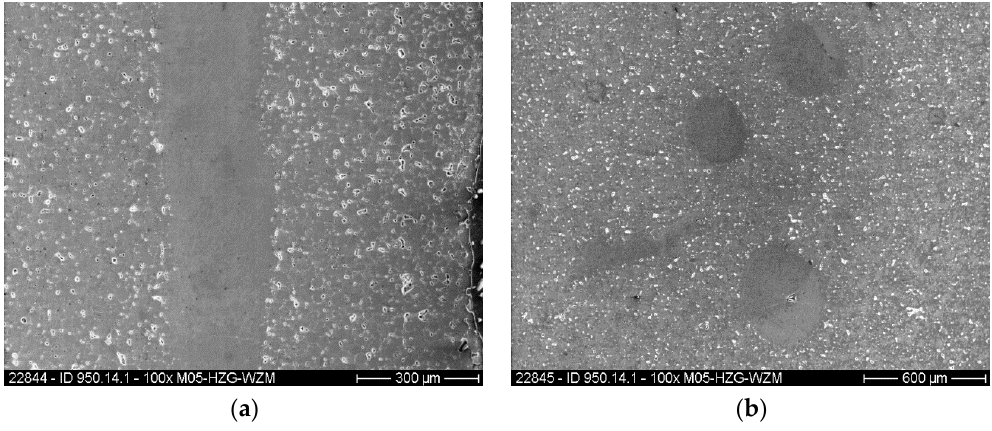
Figure A2. ( a ) SEM ‐ SE micrograph of thermal debound and sintered MIM dogbone shape tensile test specimen after 64 h sintering time using PPcoPB copolymer showing a fully enclosed jetting channel inside of the part in longitudinal direction (feedstock flow direction); ( b ) Cross section of the same specimen shown in Figure A2a.